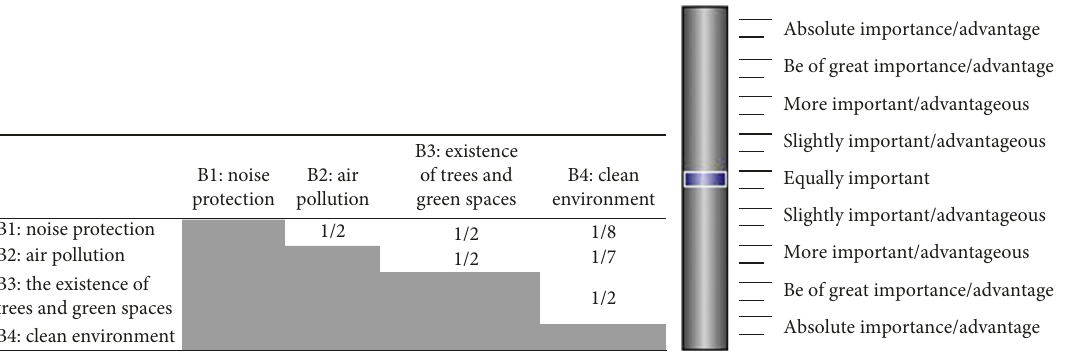
Figure 4: (a) Matrix of standard items. (b) Rating sheet of a five-point Likert